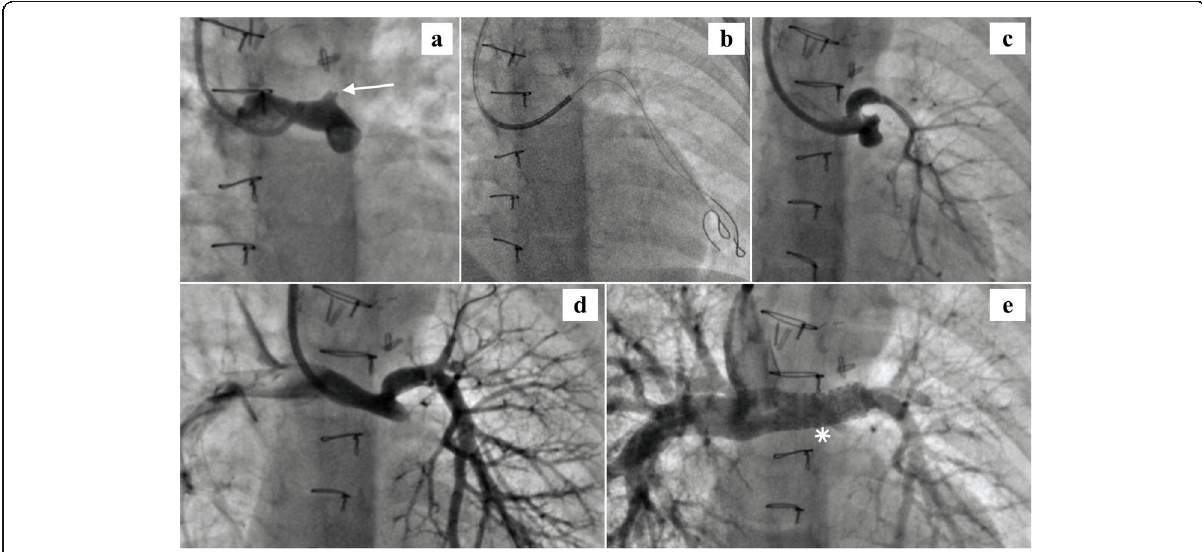
Fig. 3 Recruitment and stenting of discontinuous left pulmonary artery: a Pulmonary injection revealing the blind stump of left pulmonary artery (white arrow). b Two coronary wires parked in distal left pulmonary artery after successful recanalization. c Pulmonary angiogram after graded balloon dilatation of occluded segment shows good flow into left lower lobe but poor arborization of left upper lobe. d Repeat injection following selective upper lobar branch balloon angioplasty. All segments of left lung well perfused. e Glenn injection showing the Formula stent in situ (white asterix) with good flow across it into distal left pulmonary